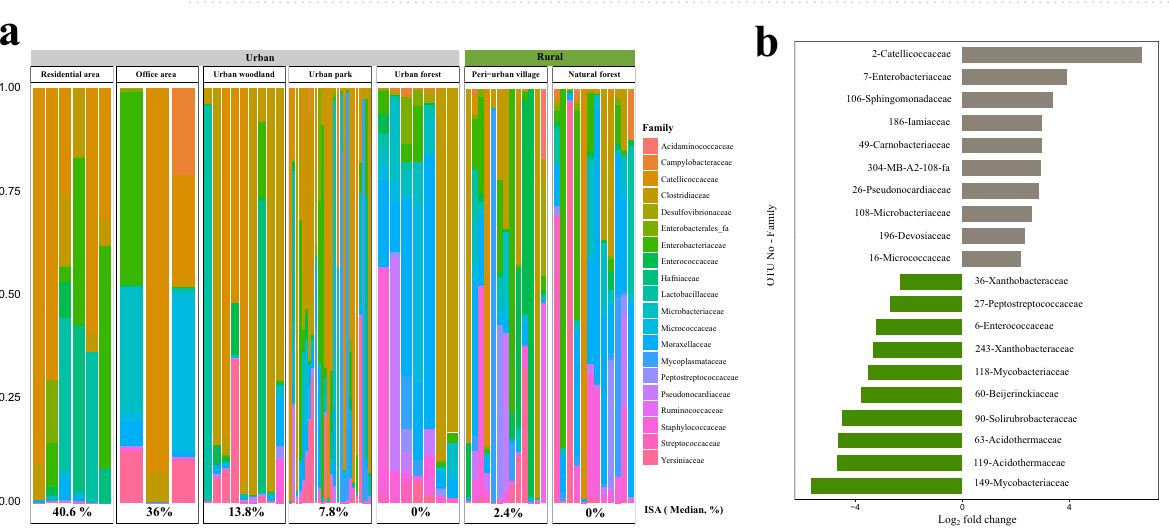
Figure 6. ( a ) The relative abundances of microbial families in gut samples from different sampling sites located in urban and rural territories. Only the 20 families with the highest relative abundances are reported. ( b ) Differentially abundant OTUs between urban and rural samples. OTUs with a log 2 -fold change larger than zero are more abundant in urban territories (grey bars), while OTUs with a log2-fold change smaller than zero are more abundant in rural territories (green bars). The family level taxonomy of each OTU is indicated. The figure was generated in R version 4.0.0 68